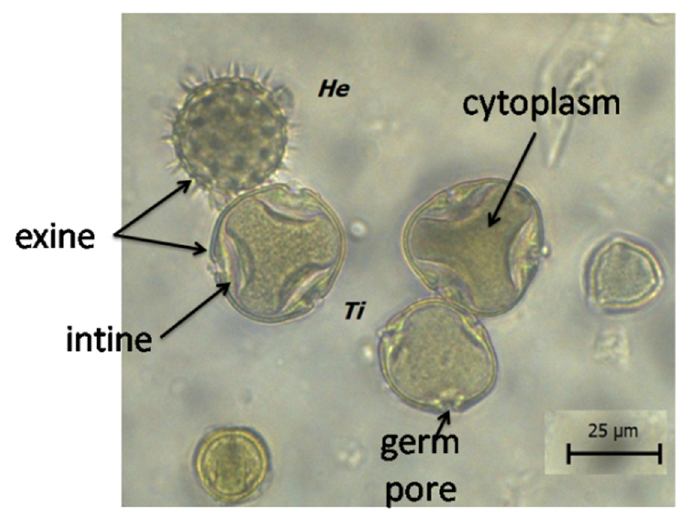
Figure 1. Pollen grain, He—Helianthus type, Ti—Tilia.